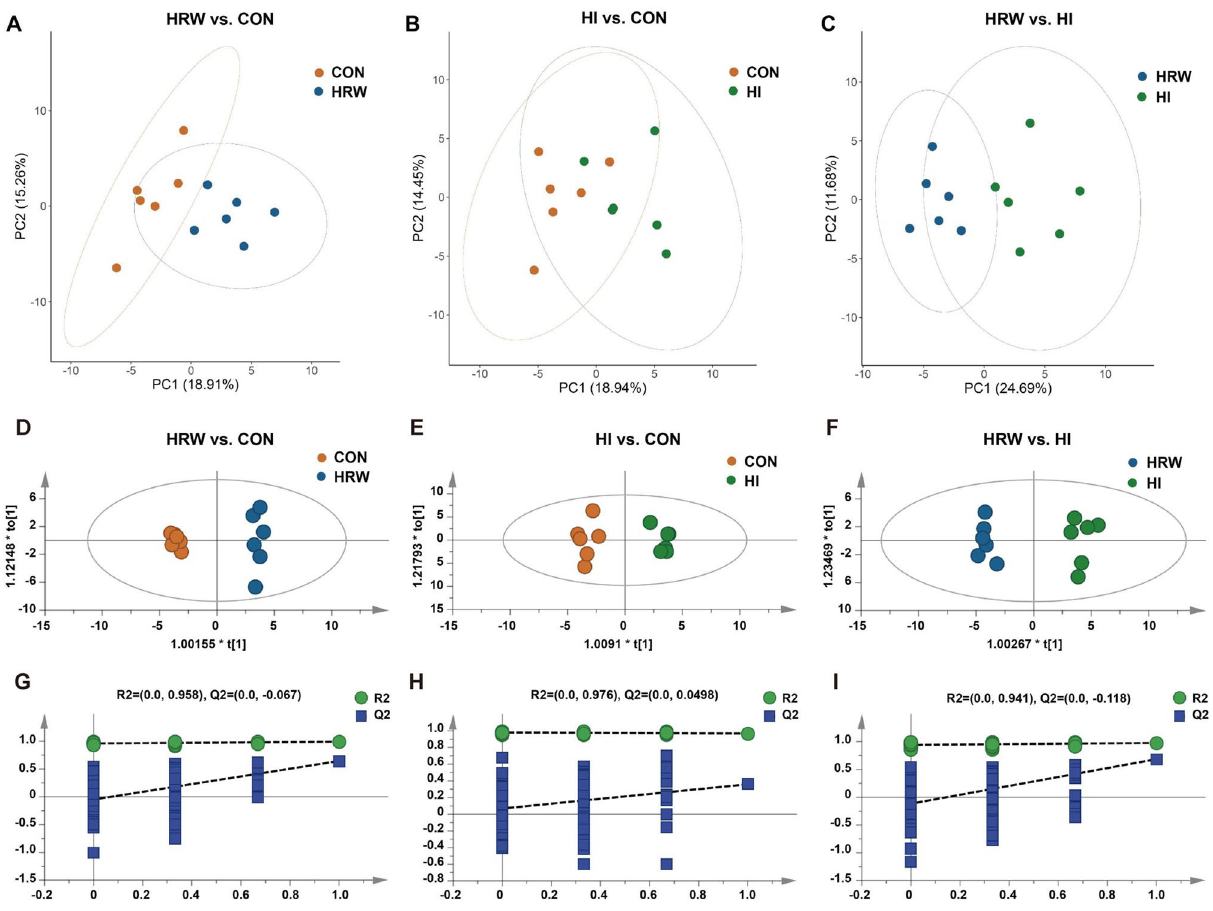
( D ) OPLS-DA score plot of HRW vs. CON; ( E ) OPLS-DA score plot of HI vs. CON; ( F ) OPLS-DA score plot of HRW vs. HI; ( G – I ) Validation plot obtained from 200 permutation tests,